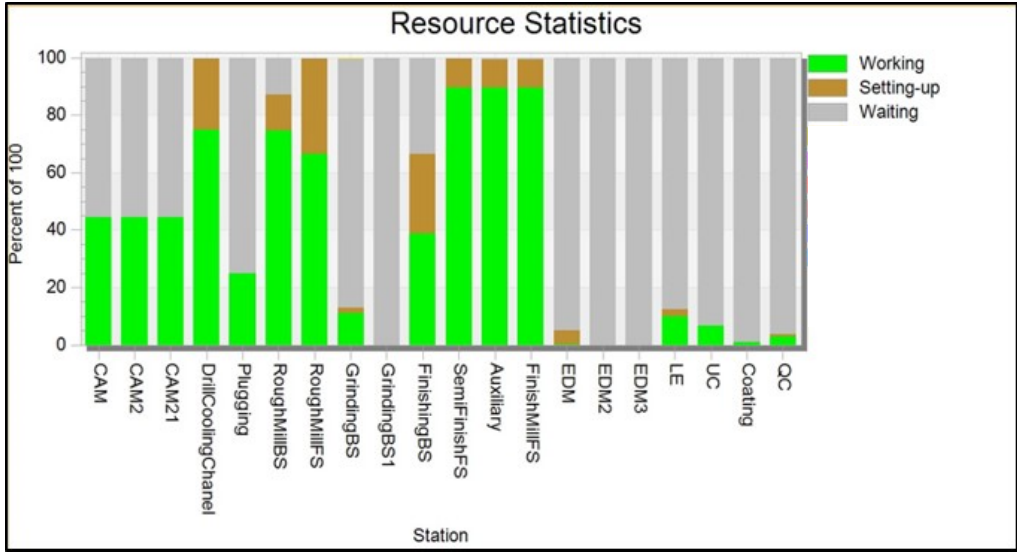
Figure 7. Resource statistics simulation for the CM workflow. The number of inserts produced in one year is 597.